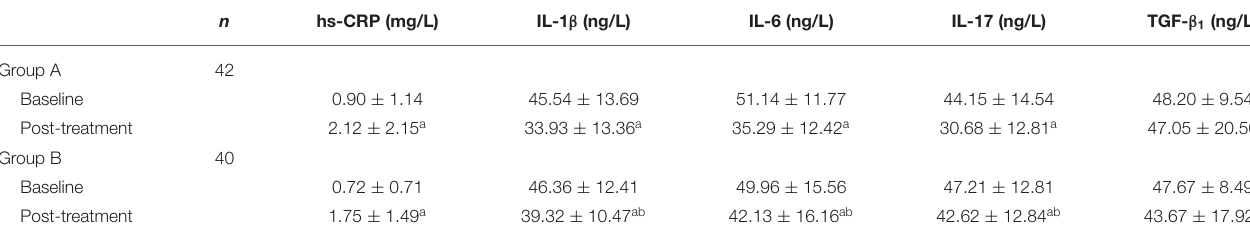
TABLE 4 | Comparison of the levels of five inflammatory factors between groups A and B before and after treatment.